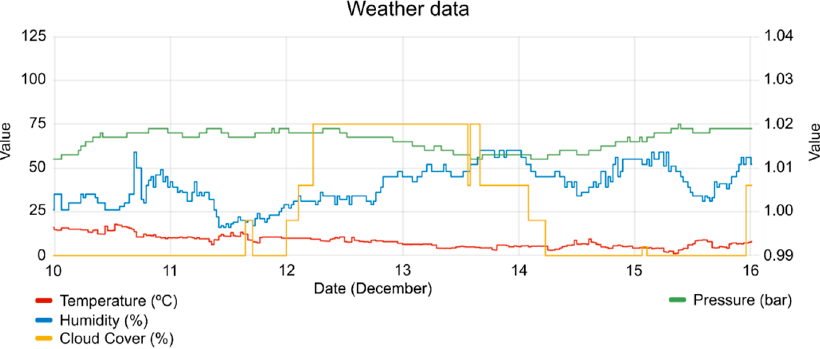
Figure 16. Temperature, humidity, pressure and cloudy during the test period.